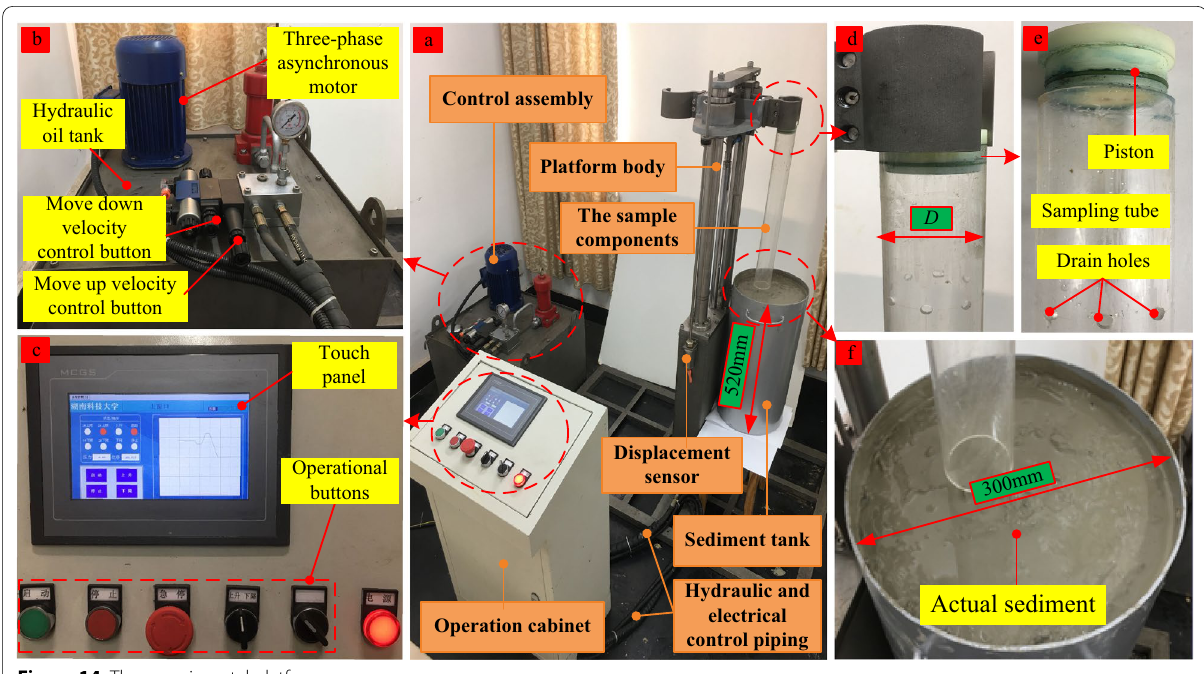
Figure 14 The experimental platform